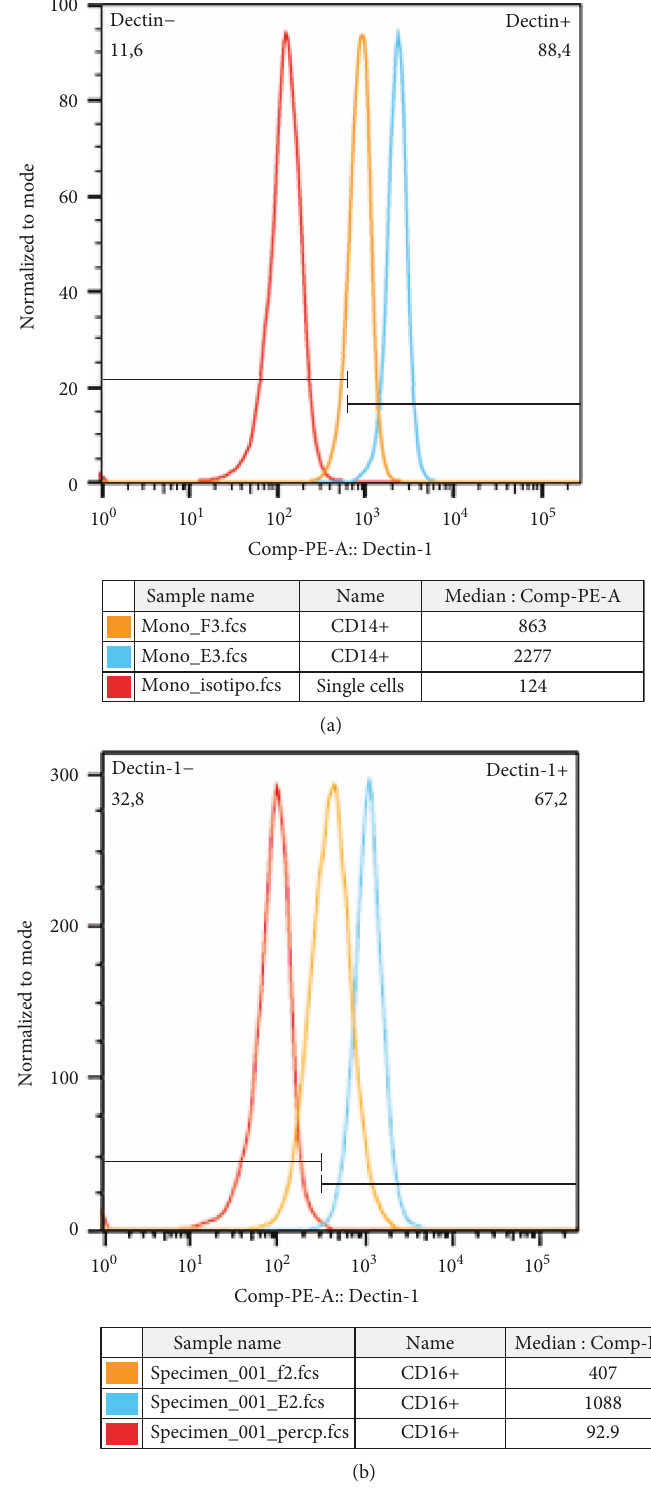
Figure 2: Histogram of a representative experiment for Dectin-1 receptor blockage for monocytes (a) and neutrophils (b), showing MFI of monocytes or neutrophil cultures (blue line) or monocytes or neutrophils treated with 3.0 μ g/mL (orange line) of anti-Dectin-1 monoclonal antibody. The red line represents MFI of the isotypic